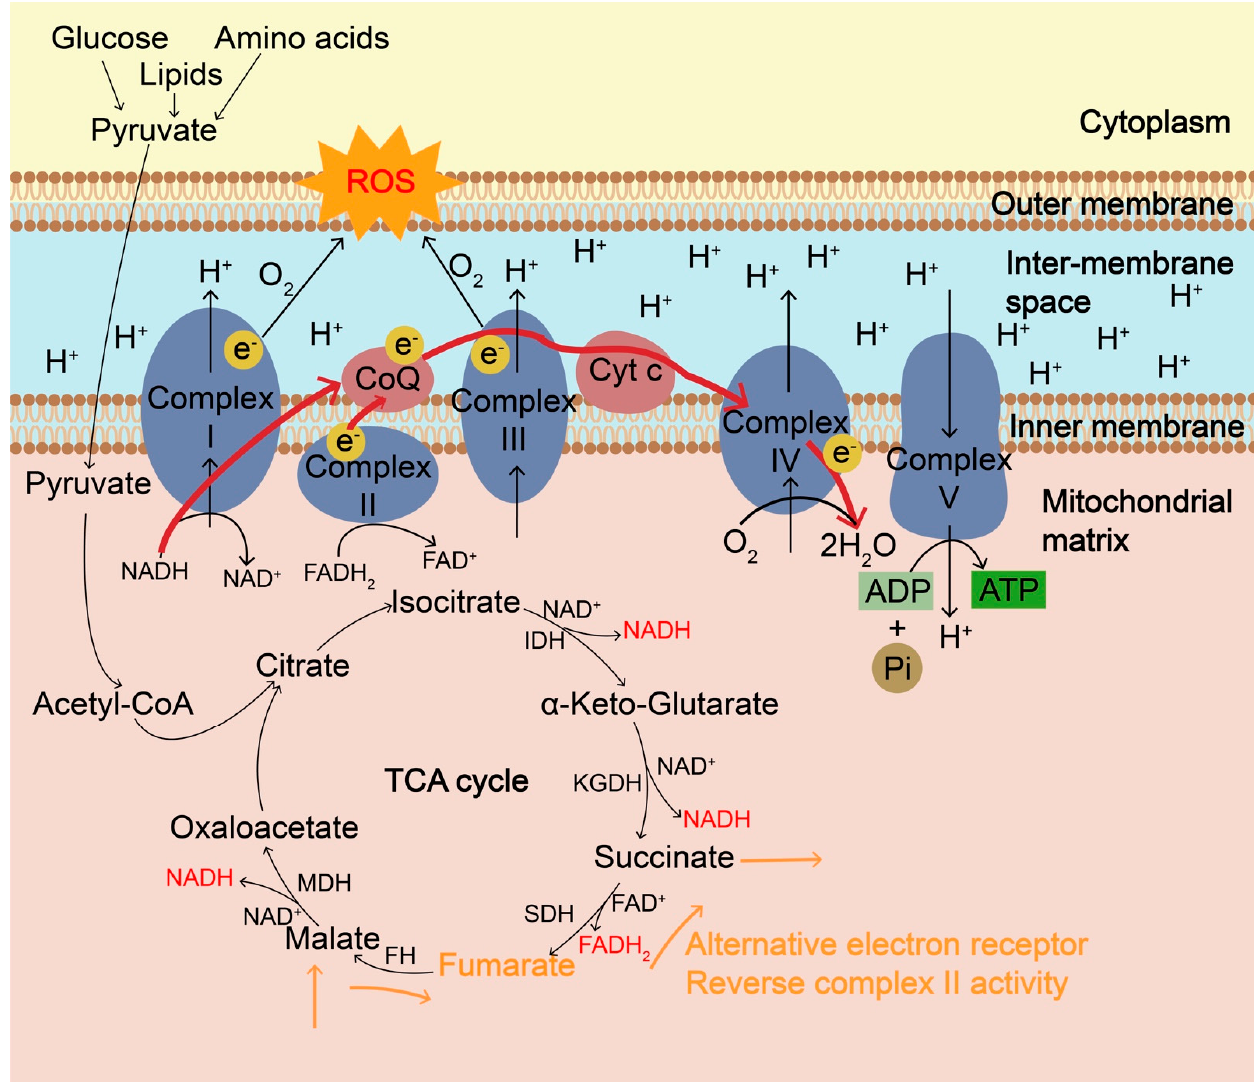
Figure 1. The mitochondrial electron transport chain (ETC) and the generation of ROS. Mitochondrial ETC, coupled with tricarboxylic acid (TCA) cycle, is the main cellular source of ROS in aerobic organisms and ROS are mainly formed as byproducts of oxidative phosphorylation during ATP synthesis. ETC is composed of four multiprotein complexes, Complex I–IV. Complex I and ubiquinone of complex III are the major sites of ROS generation. During the TCA cycle, NADH produced from isocitrate dehydrogenase (IDH), α -ketoglutarate dehydrogenase (KGDH) and malate dehydrogenase (MDH) goes to the ETC and electrons transfer to O 2 through Complex I and complex III. During hypoxia or high O 2 demand, such as oncogene activation and nutrient excess, partial one-electron reduction of O 2 can occur at complexes I and III, producing O2 •− due to electron leakage, resulting in the accumulation of ROS. ROS is also accumulated when complex IV is inhibited and electrons cannot be transferred effectively to O 2 . In addition to the ultimate electron acceptor O 2 , during hypoxia, fumarate can be a terminal electron acceptor and can accept electrons via the reverse complex II activity, during which fumarate is reversibly converted into succinate catalyzed by succinate dehydrogenase (SDH), accompanied by the conversion of FADH2 into FAD. Fumarate can shuttle reducing power through reversible conversions among malate, fumarate, and succinate catalyzed by fumarate hydratase (FH) and SDH, especially from an O 2 -poor tissue to an O 2 -rich one. ROS, reactive oxygen species; ETC, electron transport chain; TCA, tricarboxylic acid; IDH, isocitrate dehydrogenase; KGDH, α -ketoglutarate dehydrogenase; MDH, malate